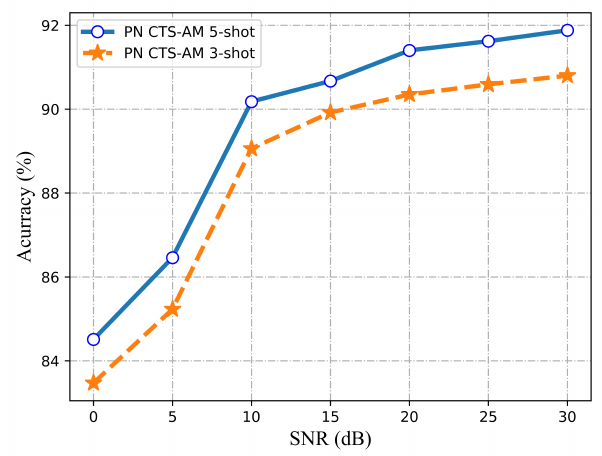
Figure 11. The average recognition accuracy with the variation in